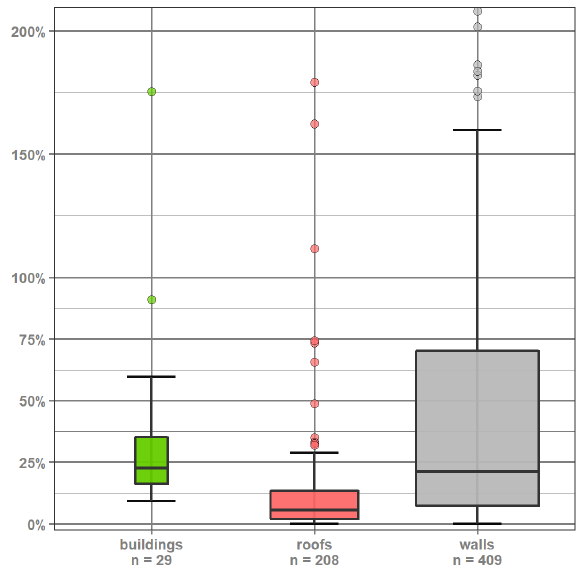
Figure 8. Box plot on the overestimation of the solar potential analysis results without mesh integration. Lower hinge = 25% quantile, upper hinge = 75% quantile. Interior line =